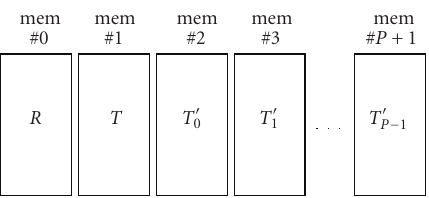
Figure 4: Local memory data storage layout in the exhaustive search algorithm for image